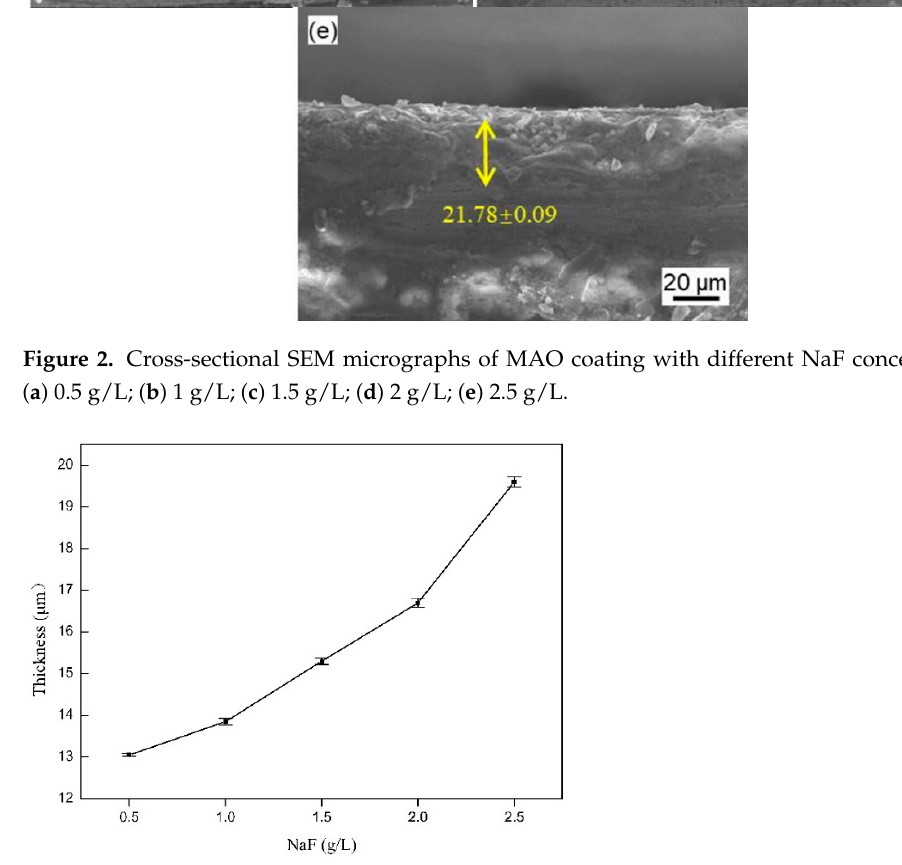
Figure 3. The thickness of the MAO coating with different NaF concentrations from 0.5 g/L to 2.5 g/L.